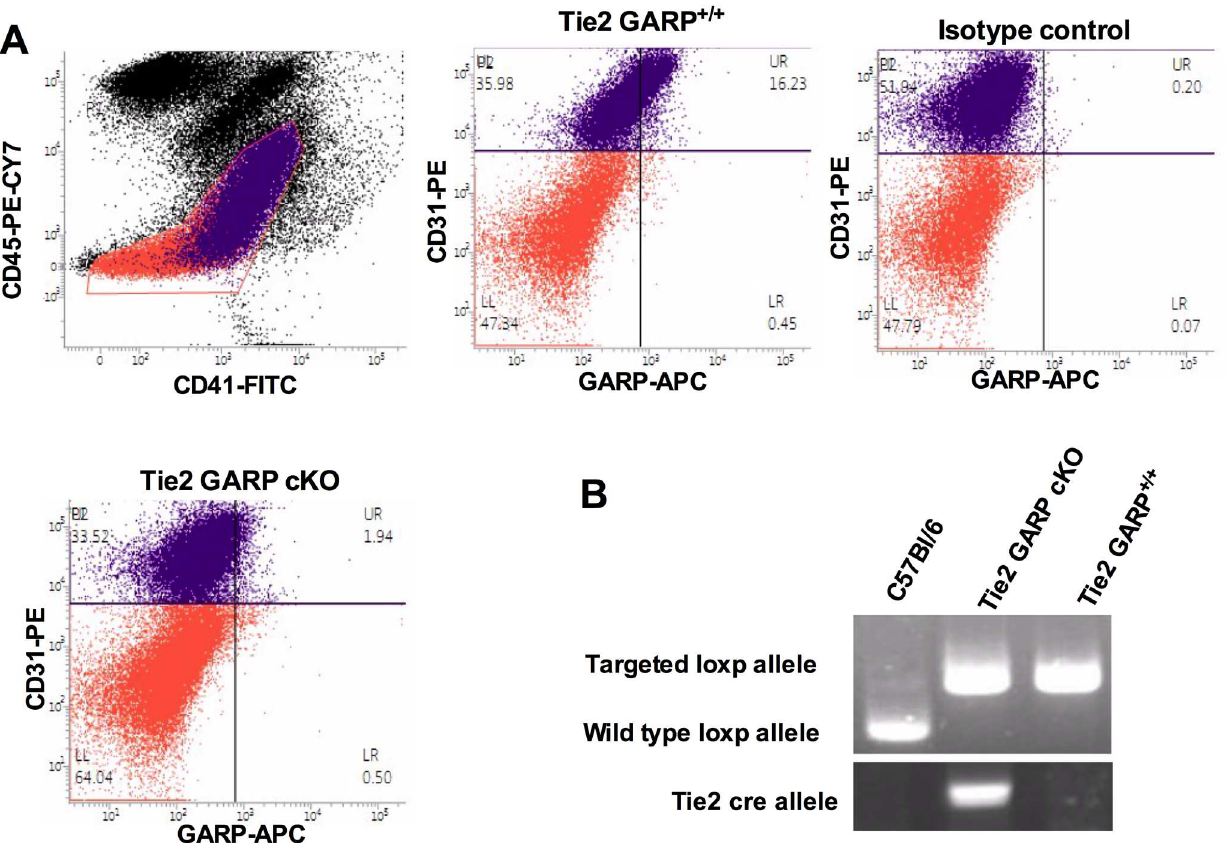
Fig 5. Generation of endothelial specific GARP knockout mice. ( A ) Phenotypic characterization of littermates and cKO mice using flow cytometry. Singlecells were labeledwith anti-CD45-PeCy7, anti-CD31-PE, anti-CD41-FITC and anti-GARP-APC and a histogramwas made based on APC intensity of CD45-CD31+CD41-population.Isotype control (black line), littermates (grey line) and cKO (black). ( B ) Genotypic analysisof genomicDNA from control C57BL/6, littermates and endothelialspecific cKO mice. Loxp is 181 bp (fl/fl); wt alleleis 111 bp, Cre 450